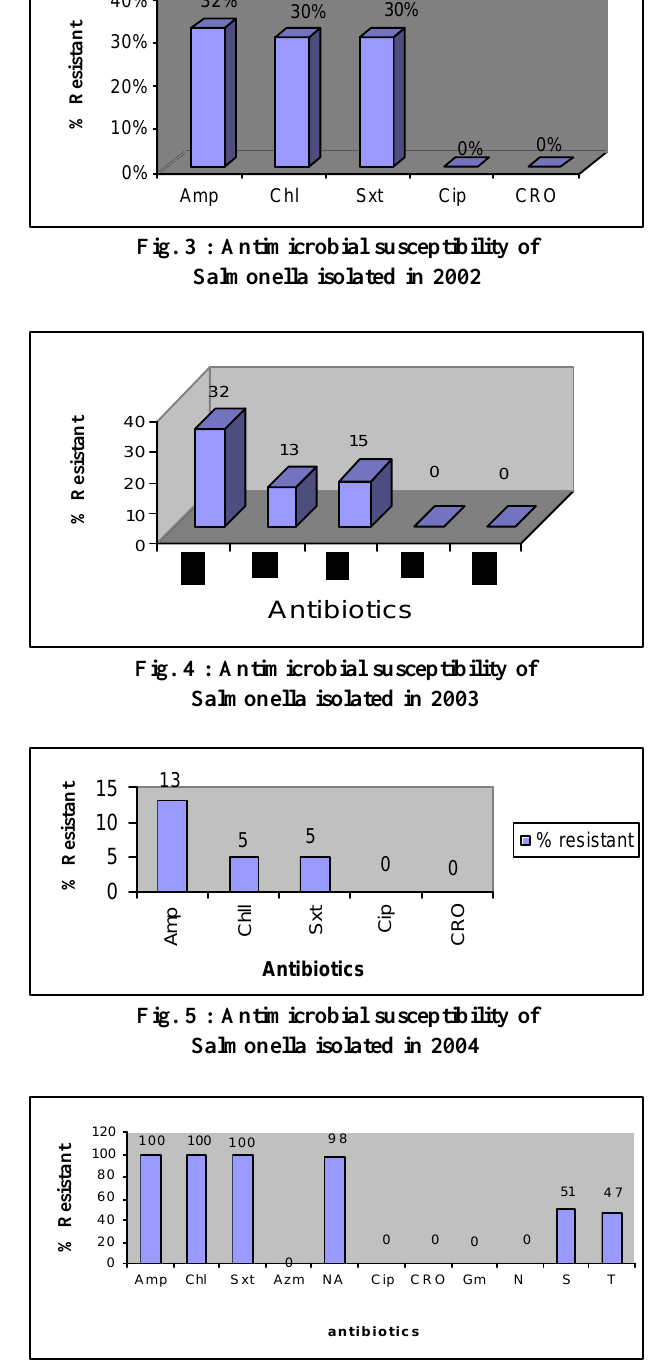
Fig. 6 : Antibiotic susceptibility pattern of multi drug resistant Salmonella rate to Azithromycin, Nalidixic acid, Gentamicin, Neomycin, Streptomycin, Tetracycline and Kanamycin were 0%, 98%, 0%, 0%, 51%, 50% and 0% respectively. (fig. 6) Plasmid